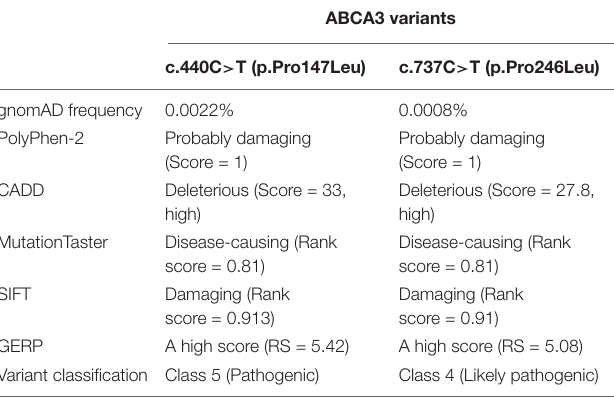
TABLE 1 | Summary of the features of the identified ABCA3 gene